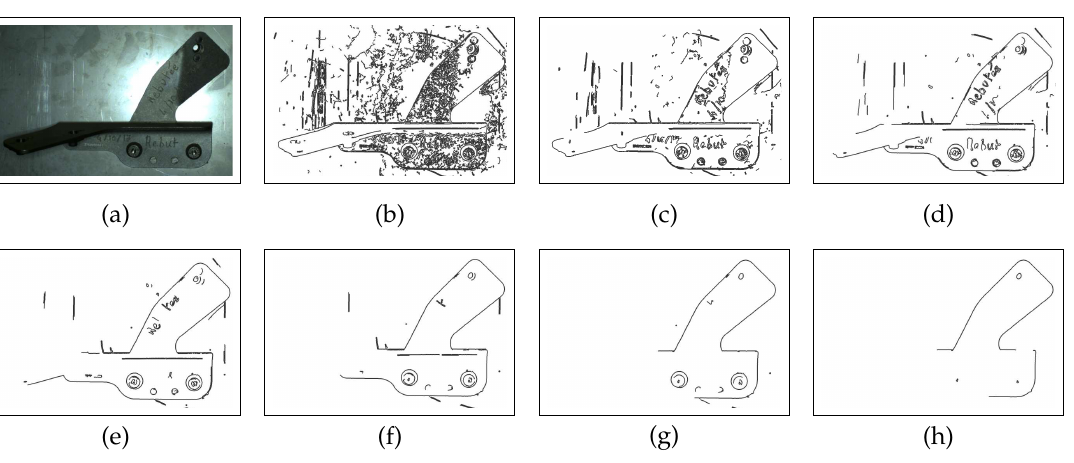
Figure 26. Images of Canny algorithm results ( a ). Images ( b – h ) have been obtained using the high and low threshold values specified in Table 4. Table 4. The proportional coefficient of high and low thresholds of Canny algorithm in Figure